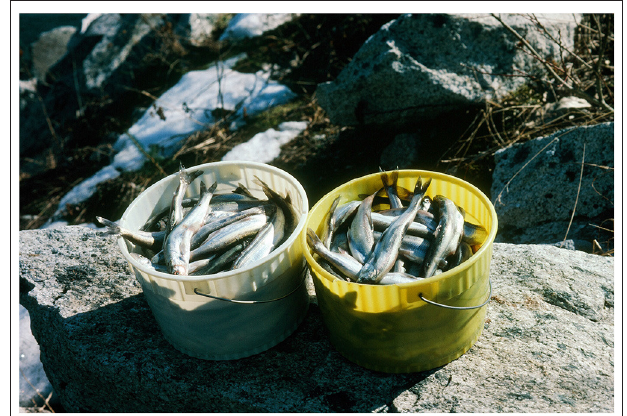
FIGURE 3 | Harvested eulachon fish, Nuxalk Nation.